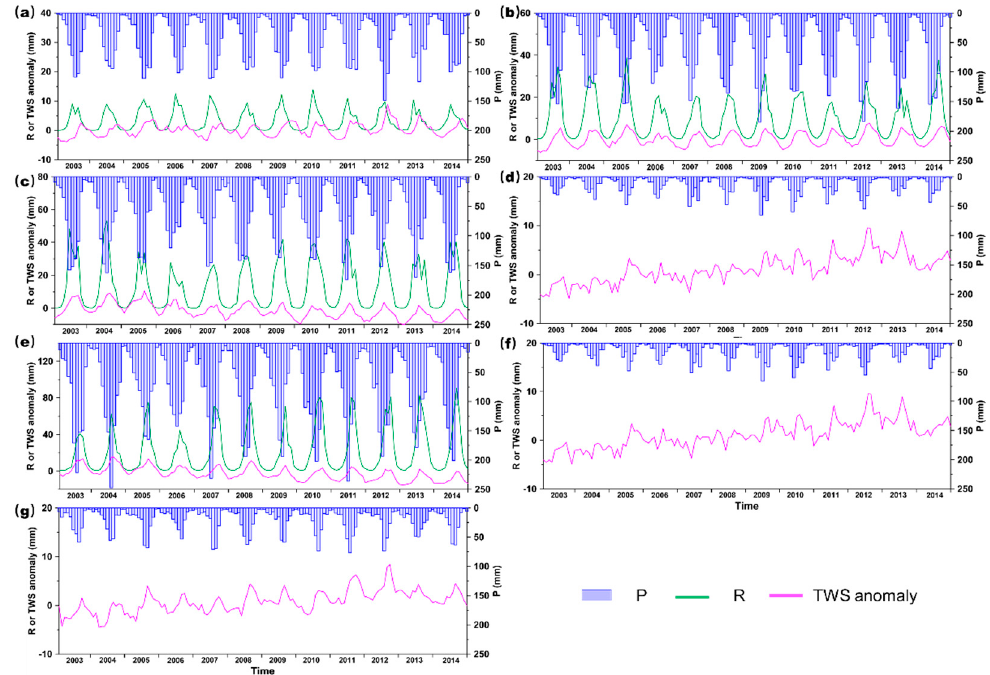
Figure 3. Monthly time series from the mean values of the precipitation(mm/month), runoff (mm/month), and the TWS anomaly (mm/month) during 2003 − 2014. ( a ) Yellow River source region; ( b ) Yangtze River source region; ( c ) Salween River source region; ( d ) Mekong River source region; ( e ) Yarlung Zangbo basin; ( f ) Qaidam Basin; and ( g ) Inner Plateau.